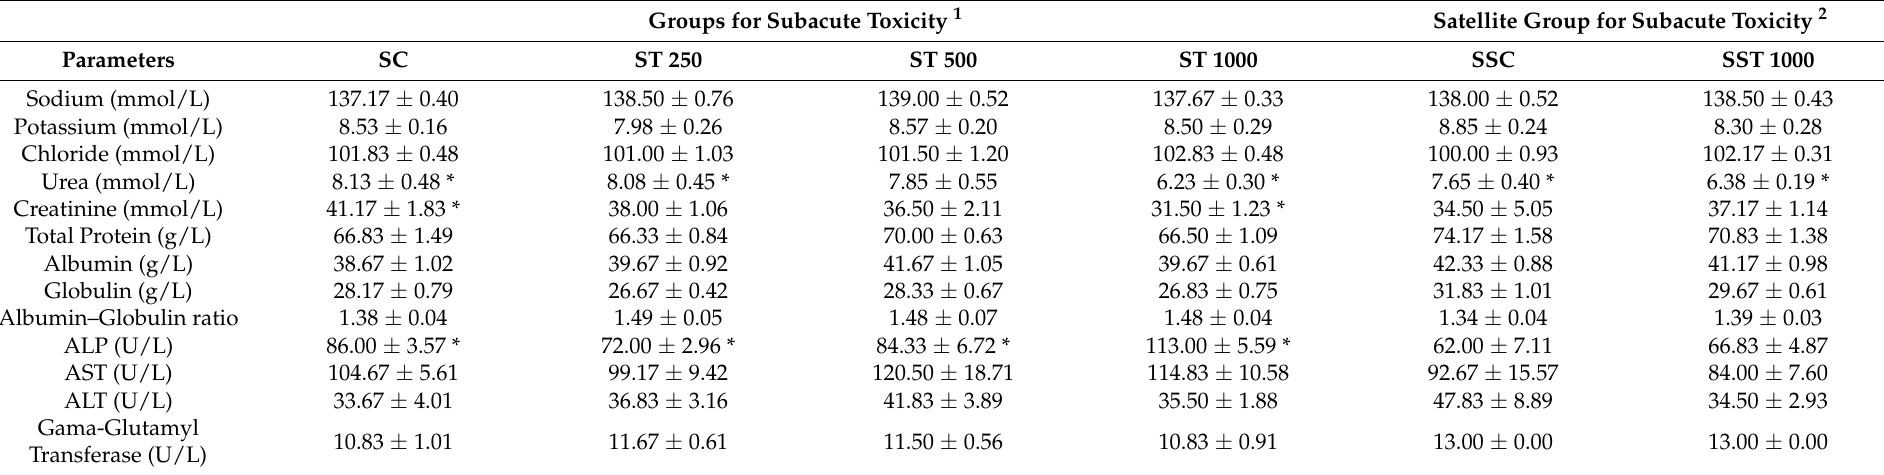
Table 11. The effects of E. tapos yoghurt on biochemistry analysis in the subacute toxicity studies. Values are expressed as mean ± SEM. (*) indicates a significant difference at p <